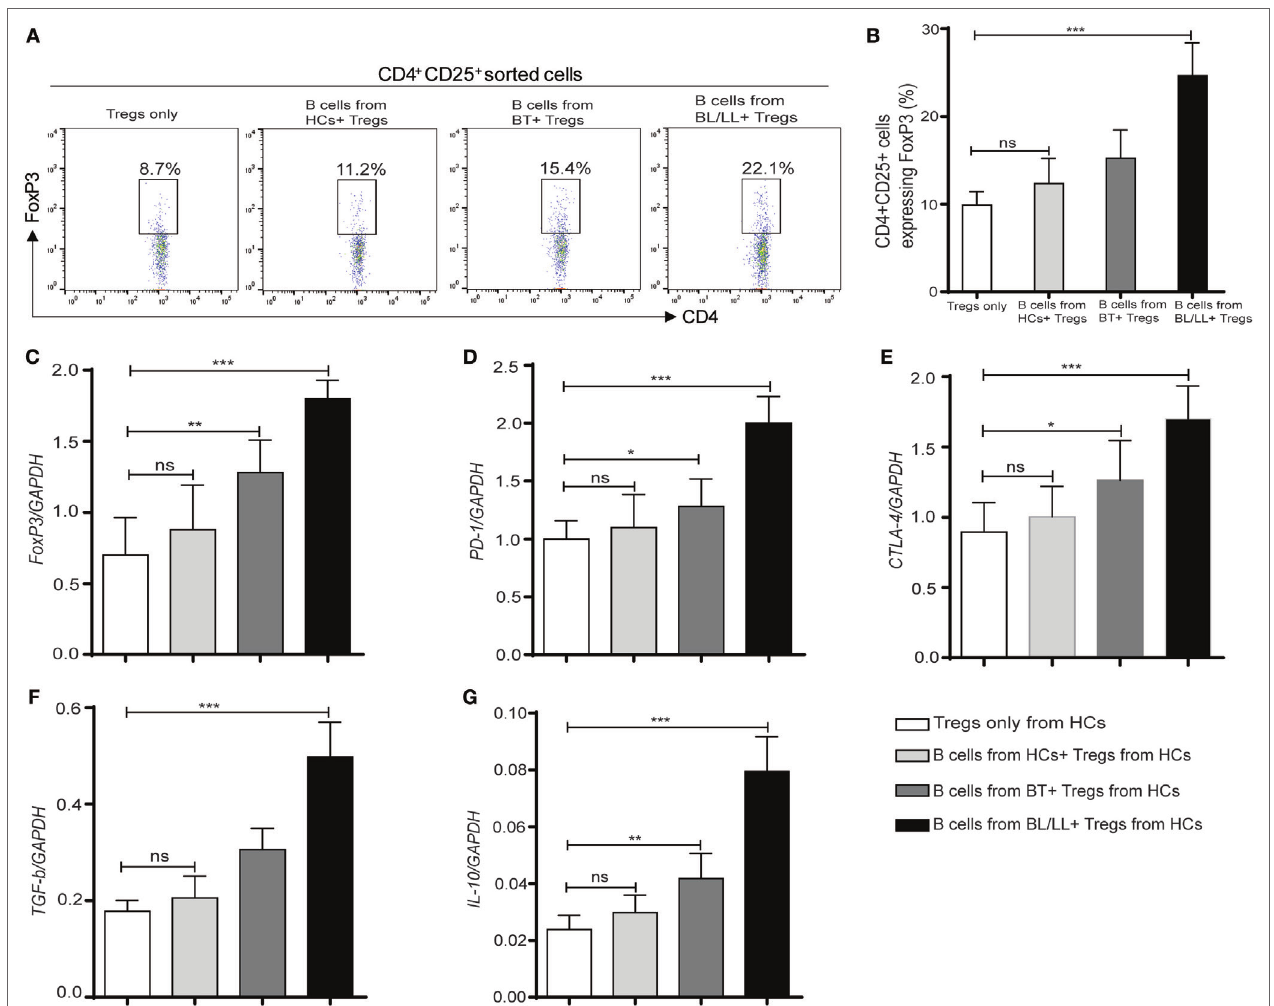
FigUre 4 | Regulatory effect of regulatory B cells (Bregs) on Tregs (CD4 + CD25 + ). (a,B) Flowcytometric and graph plot representations of CD4 + CD25 + T cells expressing FoxP3. Bregs (CD19 + IL-10 + ) derived from [HCs, borderline tuberculoid (BT) and BL/LL, n = 10] were cocultured with Tregs (CD4 + CD25 + ) derived from HCs ( n = 10) and Tregs were studied by flow cytometry. (c–g) mRNA expression of FoxP3, inhibitory molecules (PD-1, CTLA-4), TGF- β , and IL-10 in Tregs (CD4 + CD25 + ) cocultured with Bregs isolated from HCs, BT, and BL/LL ( n = 10). Mean ± SD values are shown in each set while p value < 0.05 was considered significant. 50,000 cells were acquired and analyzed by flow cytometry. Data analysis was performed with flowjo software. Statistical analysis was done using Student’s t -test for unpaired samples (* p < 0.05; ** p < 0.005; *** p <